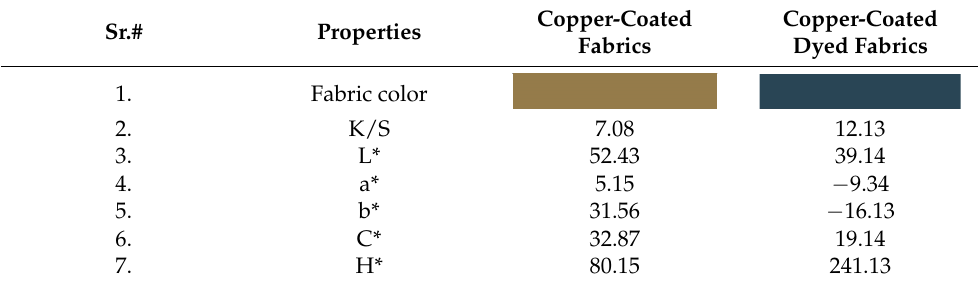
Table 3. Colorimetric data for copper-treated undyed and dyed fabric samples.